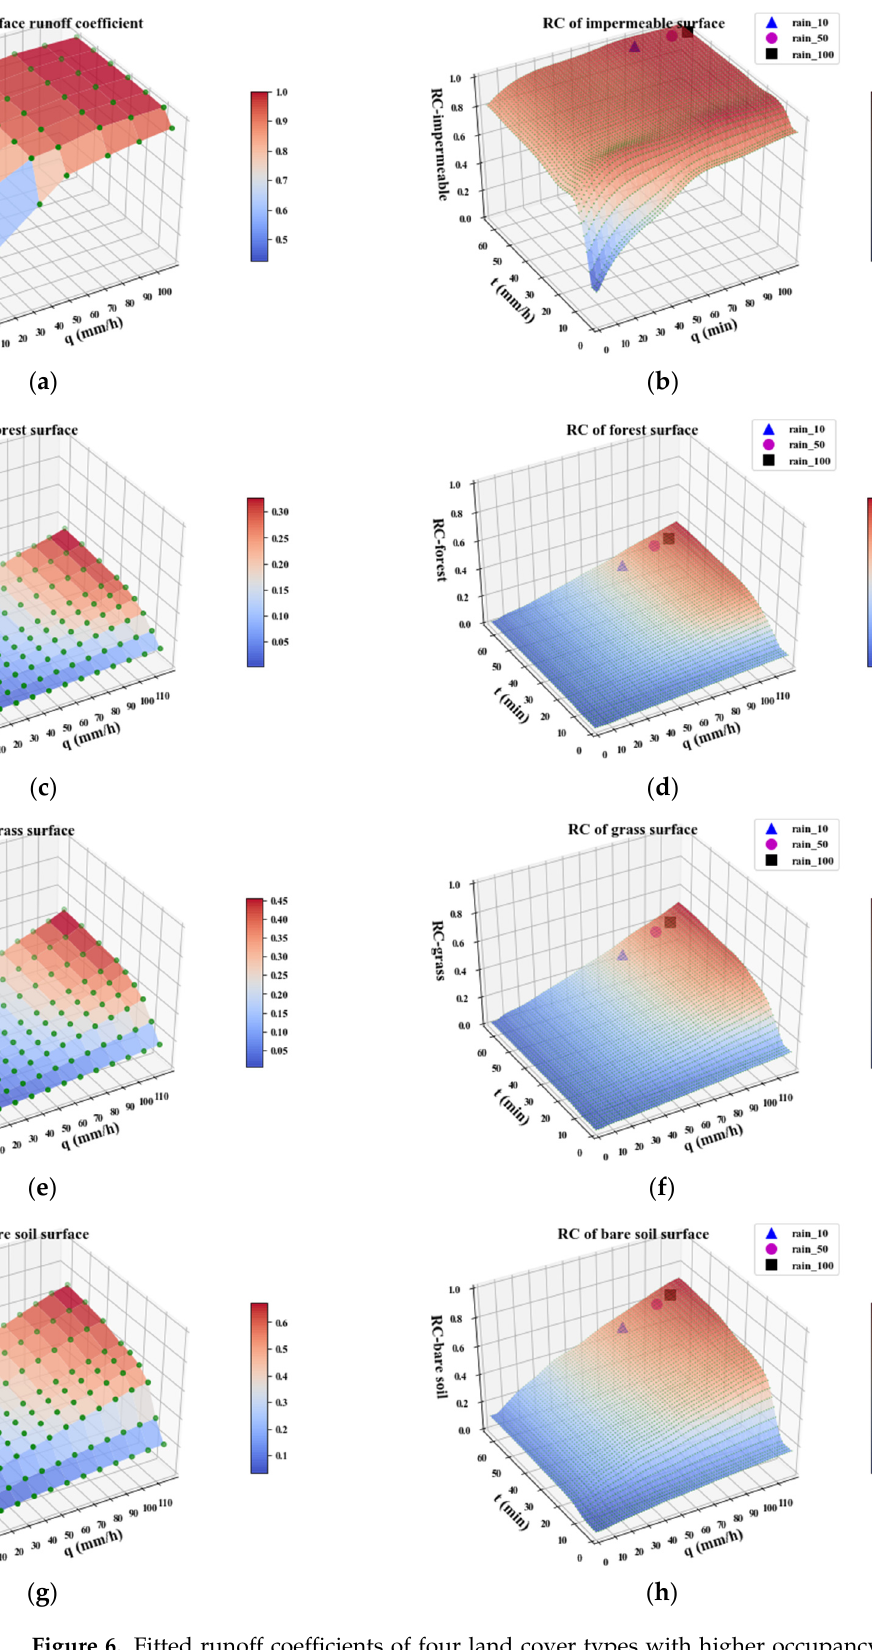
For forested land, indices such as depression and herbaceous layer thickness were